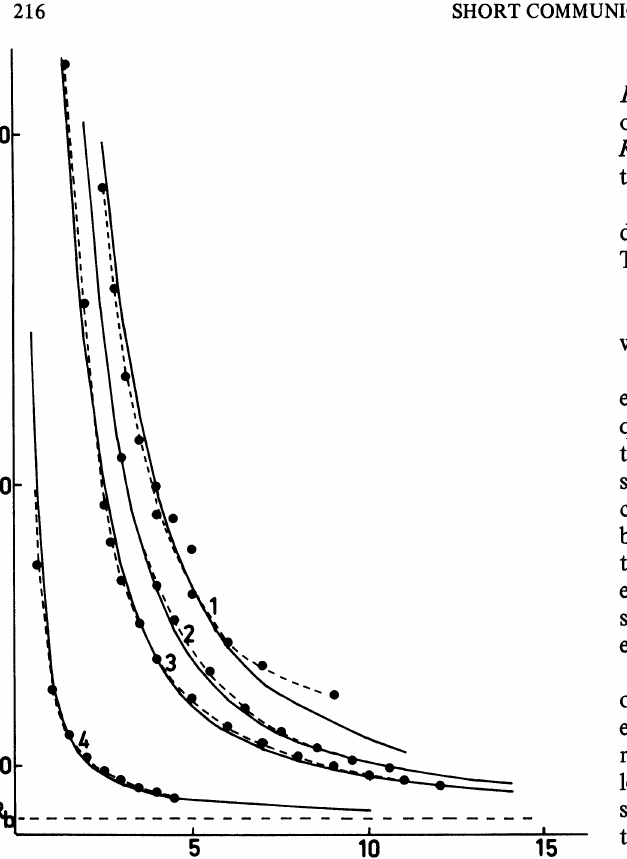
- Experimental (dotted lines) and theoretical (full lines) variations of zinc film resistance R, with sputtering rate v, equal to: (1) 80 A mn -1 (2) 110 A mn (3) 130 A mn -1 (4) 550 A mn